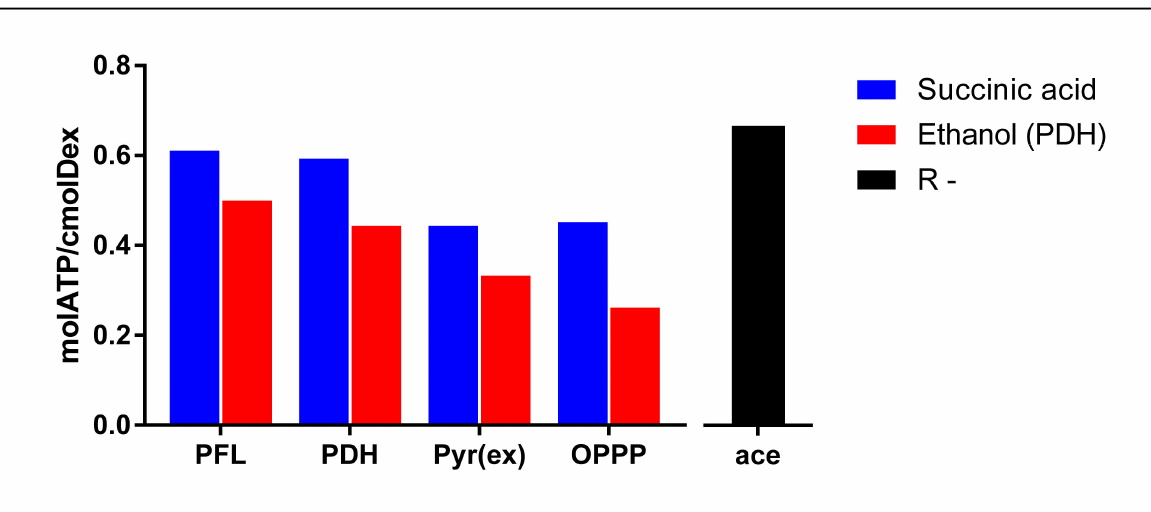
Figure 4. Visual comparison of static energy extraction efficiencies of PFL, PDH, Pyruvate excretion, and OPPP when coupled to succinic acid as redox consuming counterpart (blue) or ethanol as redox consuming counterpart (red). R-: energy extraction efficiency when reduction power is lost to the environment, producing an acetic acid (black). These numbers result from calculations based on metabolic pathways and not from experimental measured data using enzyme